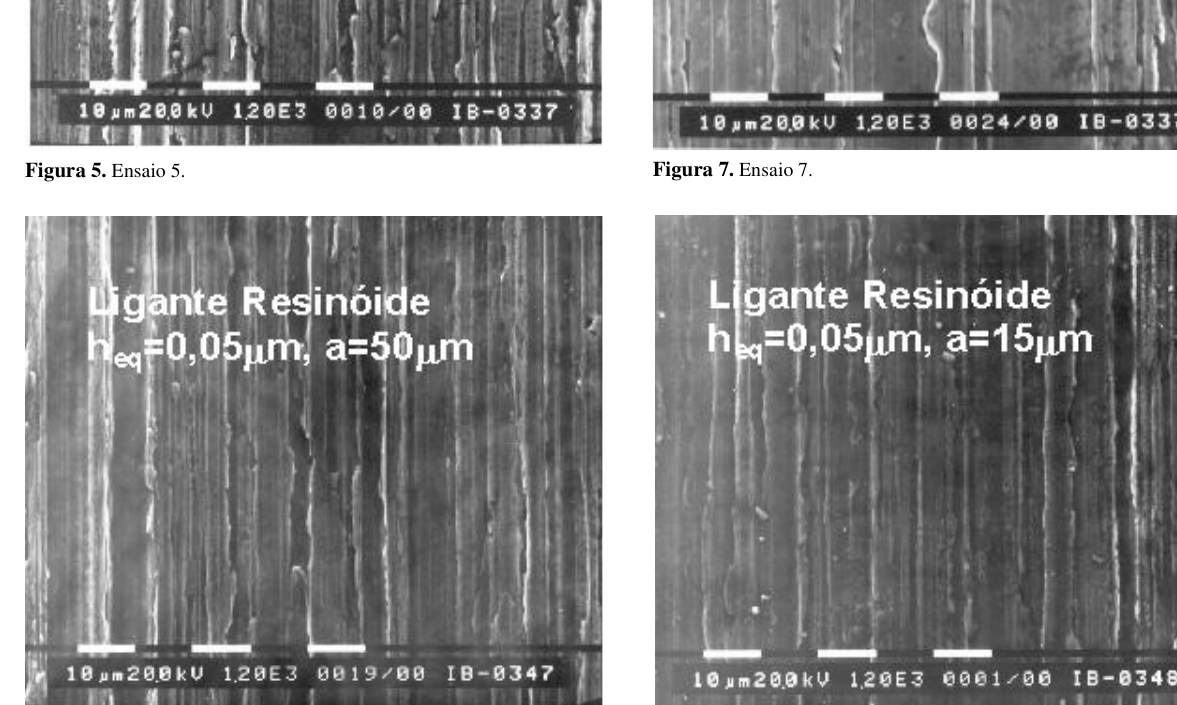
Figura 6. Ensaio 6.